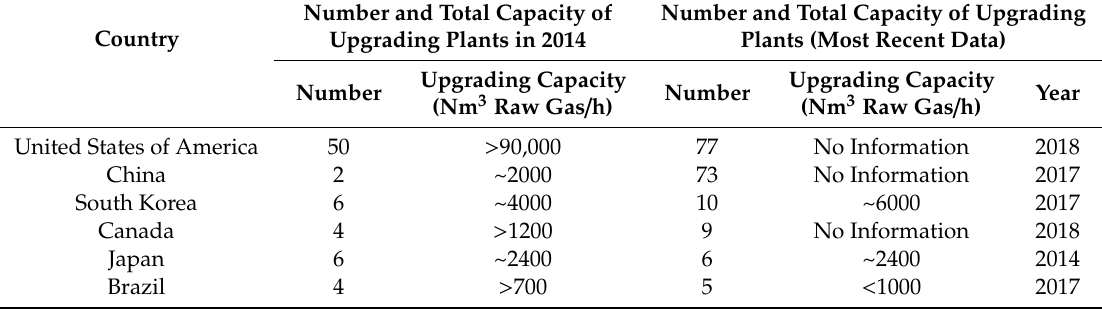
Table 2. Total number of operational biomethane plants and the total upgrading capacity in the top 6 biomethane markets outside the EU [75–78]. Number and Total Capacity of Number and Total Capacity of Upgrading Country Upgrading Plants in 2014 Plants (Most Recent Data) Upgrading Capacity Upgrading Capacity Year Number Number (Nm 3 Raw Gas / h) (Nm 3 Raw Gas / h) United States of America 50 > 90,000 77 No Information 2018 2017 Canada No Information 2018 Japan ~2400 2014 < 1000